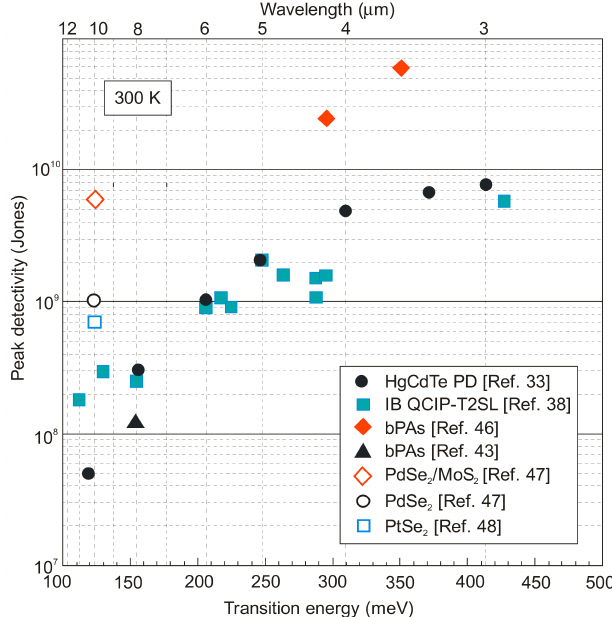
Figure 11. HgCdTe photodiodes, T2SLs InAs/GaSb IB QCIPs and representative 2D material pho- todetectors peak detectivity, D * comparison for 300 K. The measured data for HgCdTe photodiodes according to the VIGO System catalogue [33]. Data for IB QCIPs extracted from selected papers [38]. Data for selected 2D materials is taken from [33,38,43,46–48].